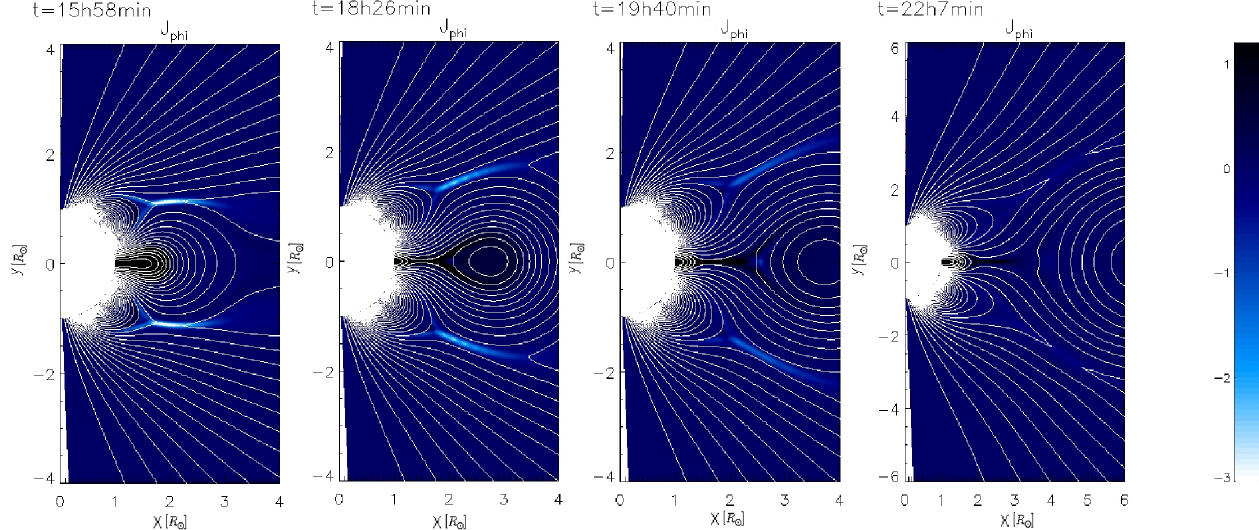
Fig. 5. Snapshots showing the current density and magnetic field lines at different times during our simulation. The left panel shows the current density at t =15h 58min. The second panel shows the reconnection at t =18h 26min when the expanding central arcade pushes the northern and southern streamers and induces reconnection. The third panel shows the current density at t =19h 40min while the fourth panel shows the current density at t =22h 7min. Here the tops of streamers have already